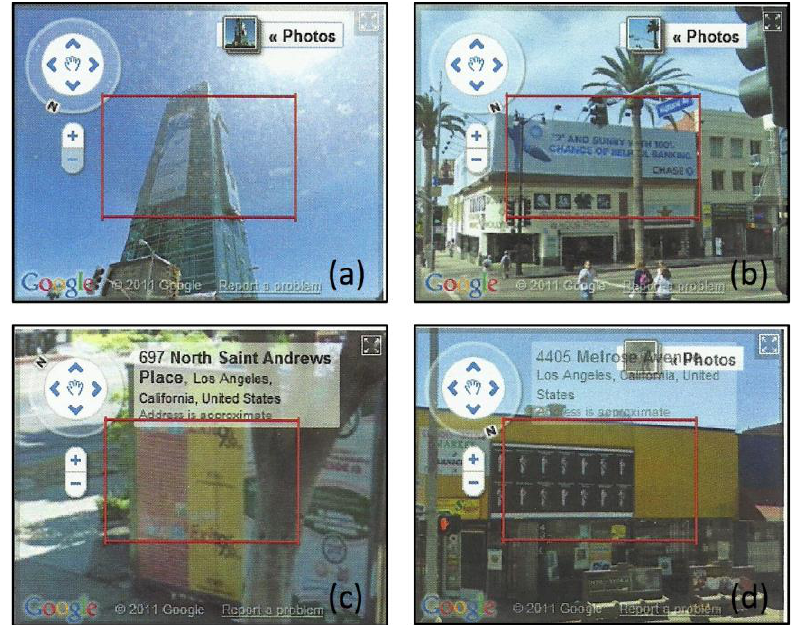
Figure 6. Sample Google Screen View images of Billboard Map entries, showing “excess” data points of signage not col- lected by city